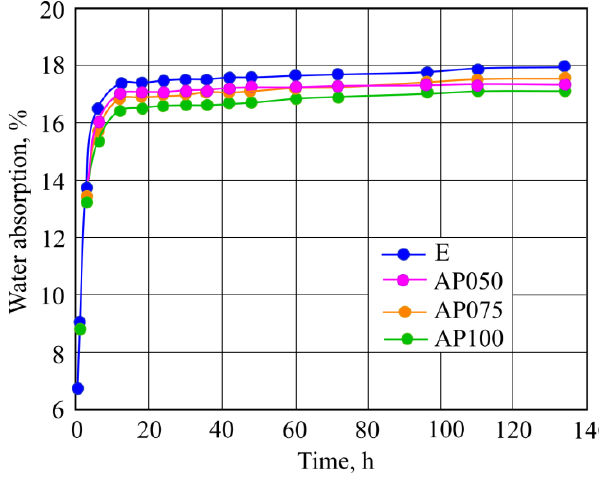
Figure 6. Results of water absorption of the samples.